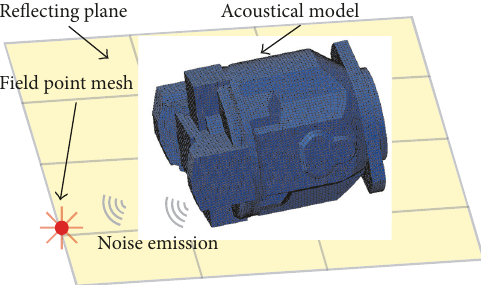
Figure 13: Acoustical boundary element model.